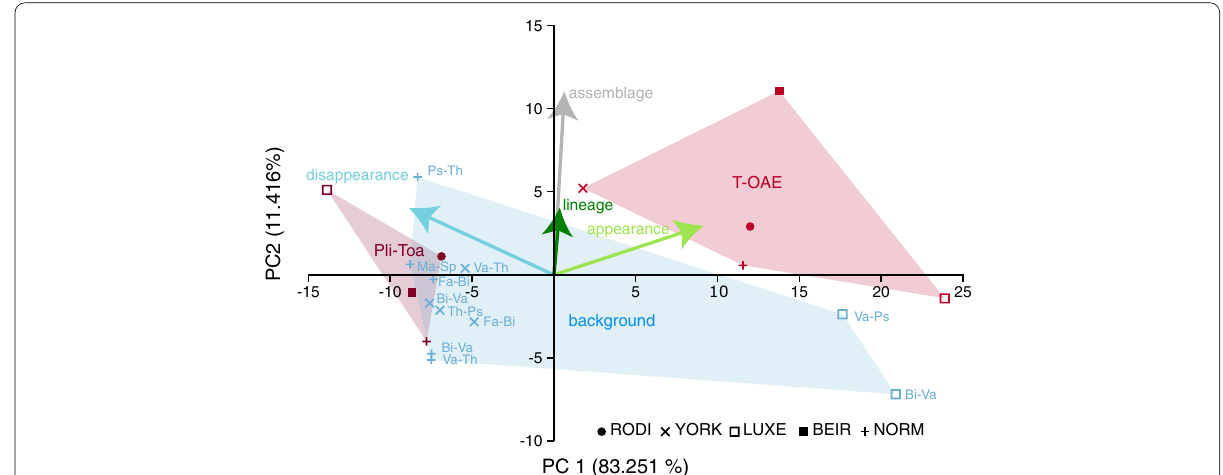
Fig. 6 PCA biplot plotting the median size changes between assemblages attributable to zones and their components (assemblage: size changes seen within entire assemblage; lineage: size changes within lineages crossing the boundary; appearance: size changes drive by specimens appearing; disappearance: size changes driven by specimens appearing). Observations are grouped based on the transition from Spinatum– Tenuicostatum Zone (Pli‑Toa crisis), Tenuicostatum–Serpentinum Zone or Serpentinum–Bifrons Zone (T‑OAE) and all others